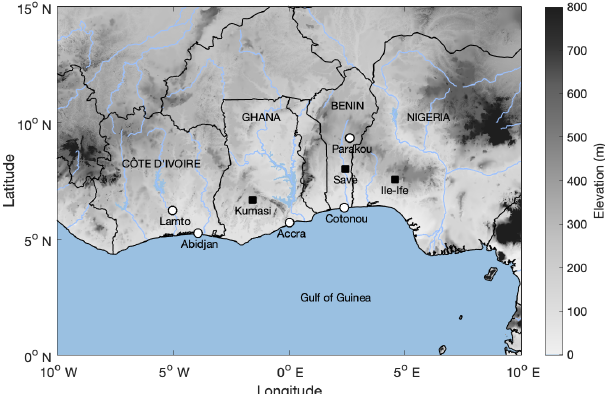
Figure 1. Geographical map of the DACCIWA study region. The location of the three DACCIWA supersites is indicated with black squares. The white dots indicate the location of radiosonde mea- surements performed as part of the radiosonde campaign along the coast in Abidjan (Côte d’Ivoire), Accra (Ghana) and Cotonou (Benin) and inland at Lamto (Côte d’Ivoire) and Parakou